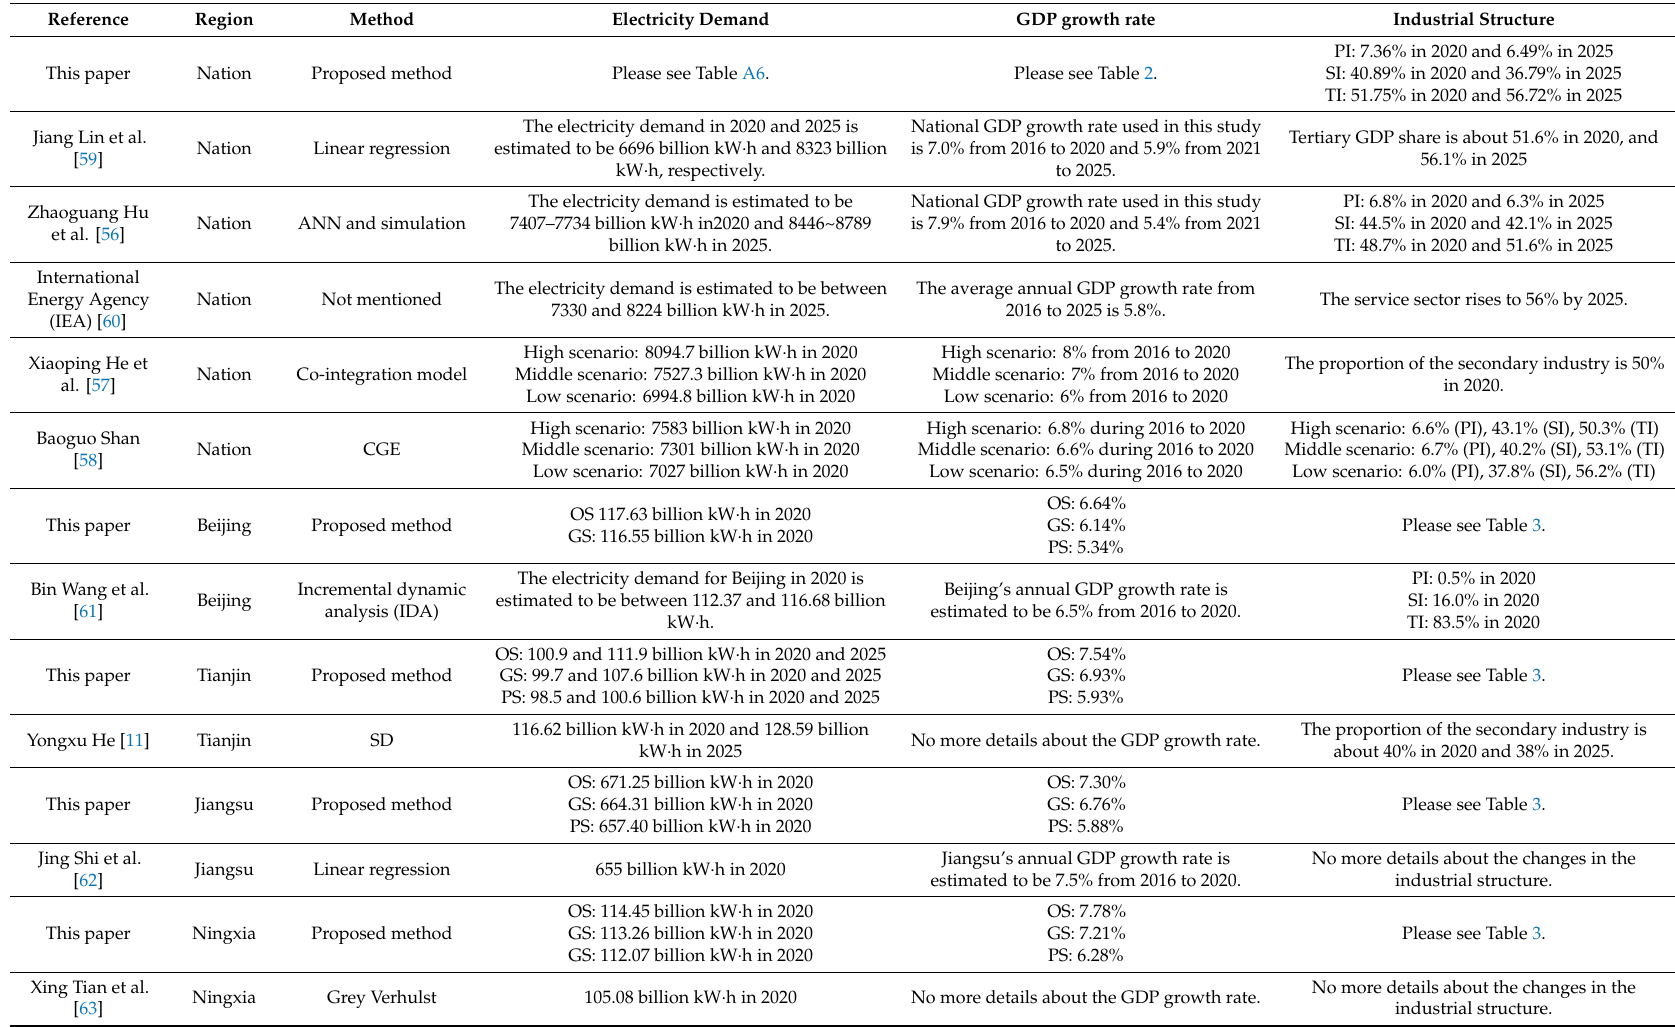
Table A8. Comparison to similar studies. CGE: computable general